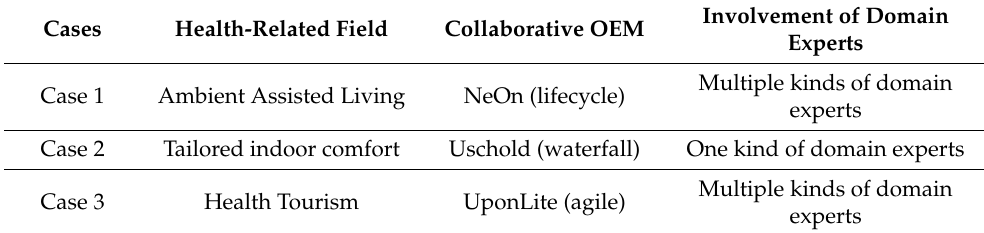
Table 2. Overview of the three